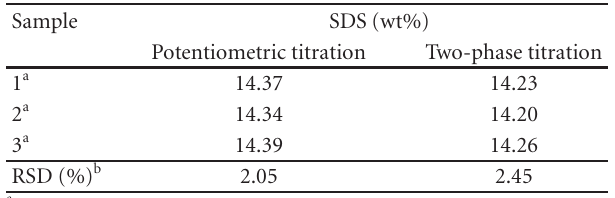
is the (cid:0) and (cid:0)